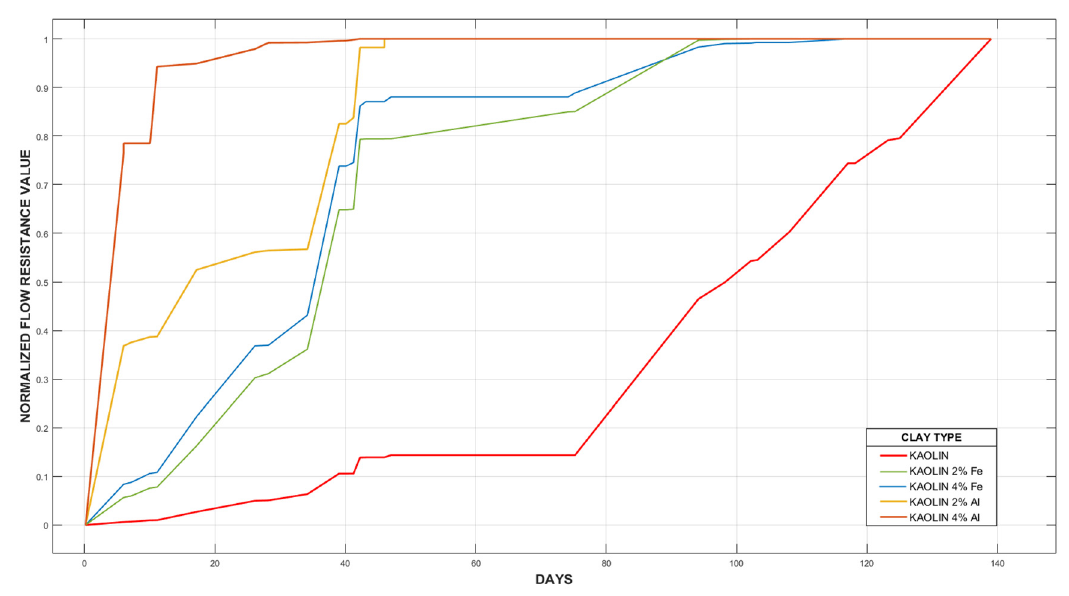
Figure 4. Normalized FR analysis for different types of kaolin clay samples.